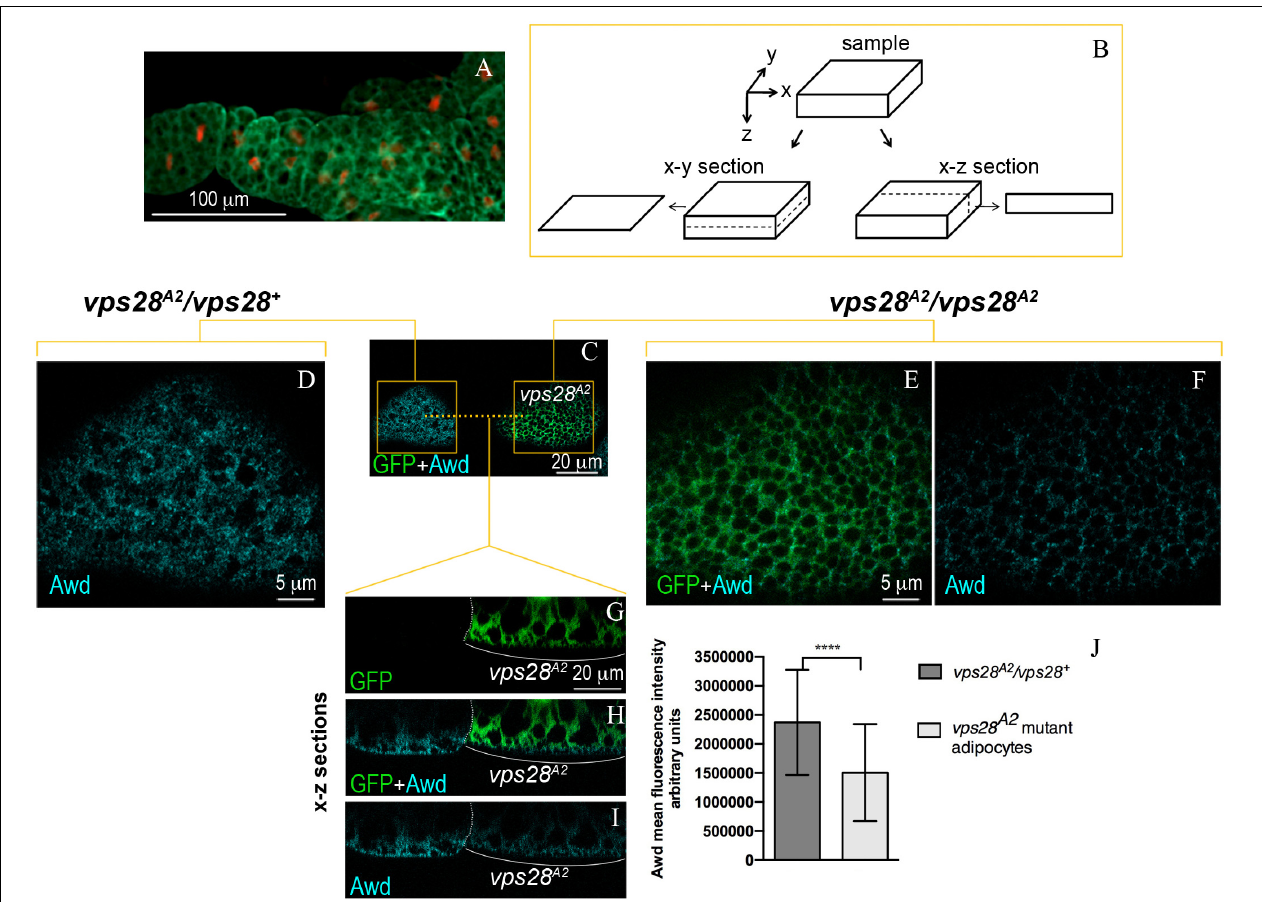
FIGURE 1 | Intracellular distribution of Awd in larval fat body. (A) Epifluorescence image of Awd protein expression (green) in fat body dissected from stage L3 larvae carrying the His2Av-mRFP transgene whose expression marks DNA (red). (B) Schematic representation of confocal optical sections of a sample in x-y and x-z planes. (C–I) Confocal microscopy analysis of vps28 A2 MARCM clones marked by GFP expression ( C,E , G , H , green) stained for Awd ( C,D , F , H , I , cyan). (C) Surface section (x–y) of mosaic fat body showing a control heterozygous vps28 A2 / vps28 + and a mutant vps28 A2 / vps28 A2 adipocyte marked by GFP expression. (D) Magnified view of the control vps28 A2 / vps28 + adipocyte (left orange box in C ). (E,F) Magnified view of the mutant vps28 A2 / vps28 A2 adipocyte (right orange box in C ). (G – I) x–z sections of the adipocytes through the planes indicated by the orange dashed line in C . The white dotted line outlines the boundary between the control and mutant adipocyte. The white bracket indicates the mutant adipocyte. (J) A severe and significant decrease of Awd signal ( p = 0.000085) is detectable in vps28 A2 / vps28 A2 adipocyte. Graphs represent mean ± SD amount of Awd in arbitrary units; n = 7; ∗∗∗∗ p < 0.0001 (two-tailed, paired t-